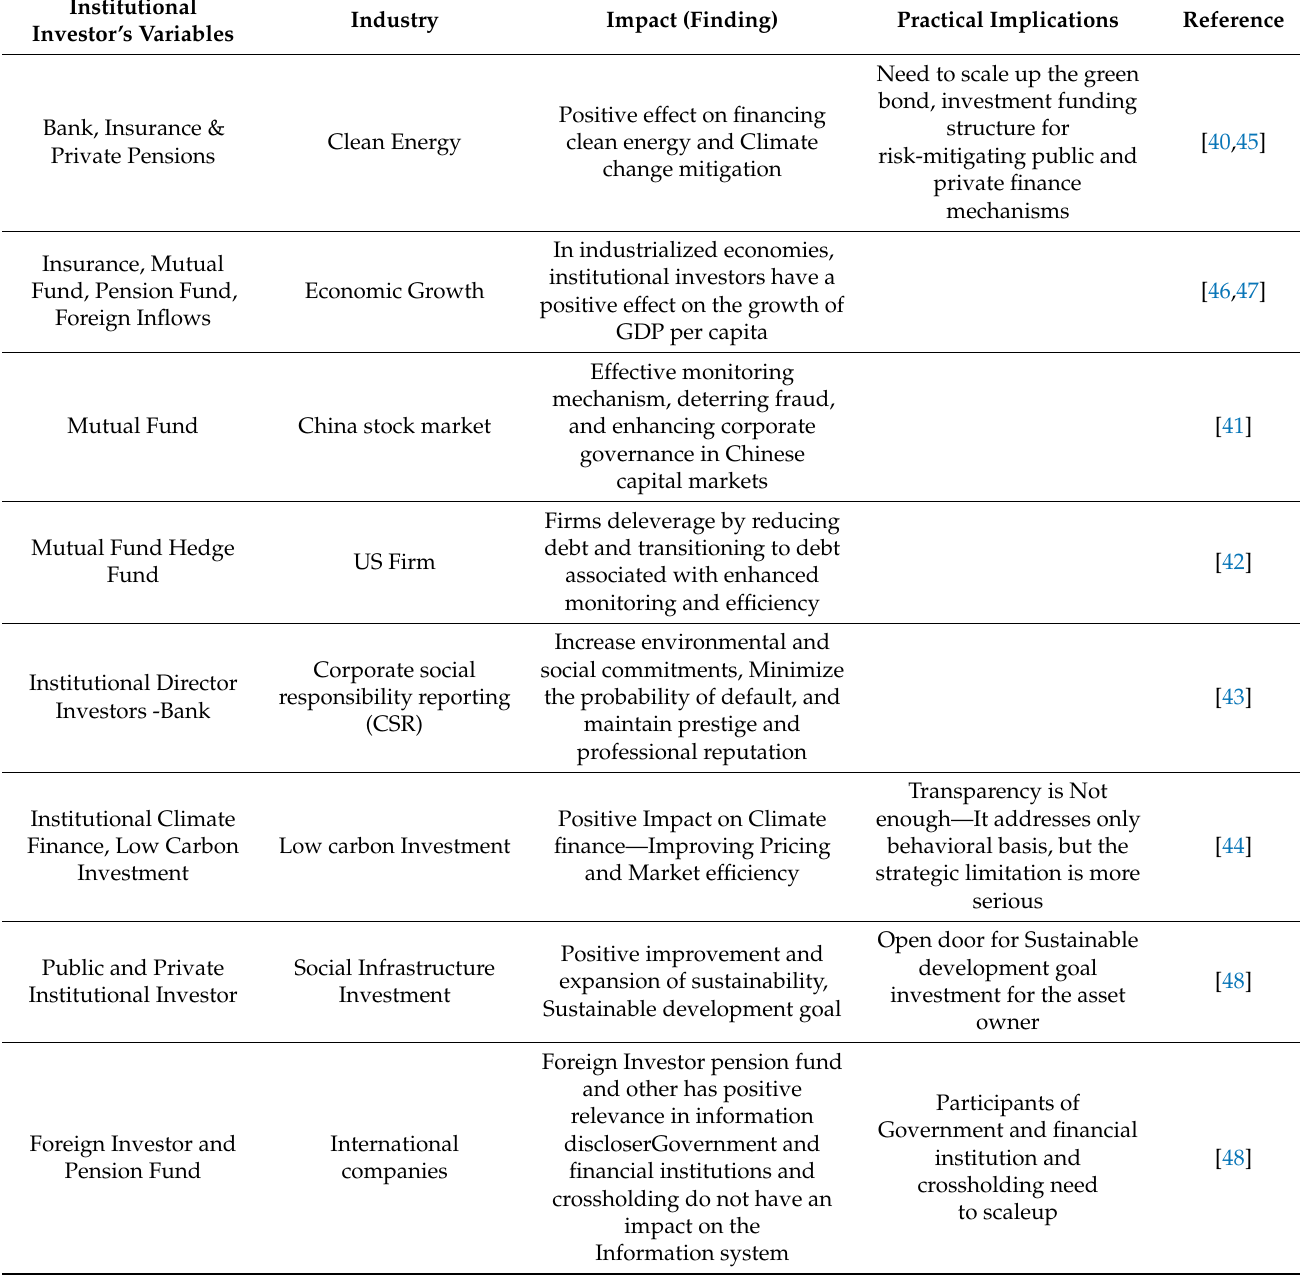
Table 1. Literature review in the field of institutional